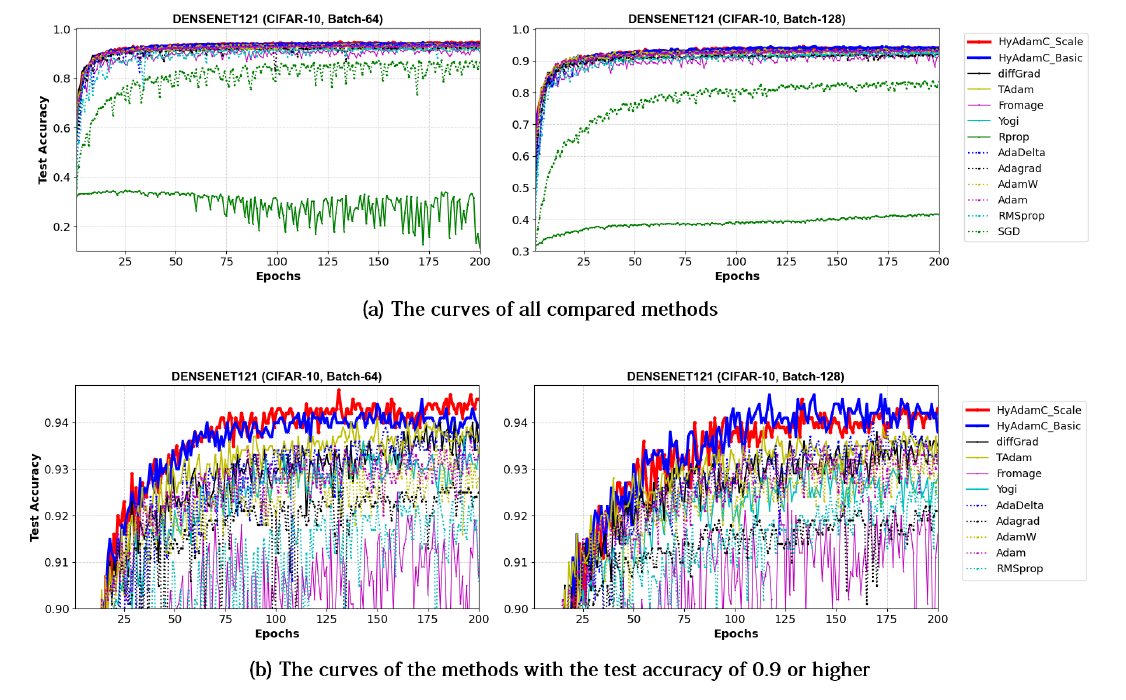
Figure 23. The test accuracy curves of the DenseNet-121 trained by HyAdamC and other optimization methods in the CIFAR-10 image classification tasks. In this figure, ( a ) shows the test accuracy curves of all compared methods. On the other hand, ( b ) illustrates the plots in which a range of the y-axis of the plots described in ( a ) is zoomed into between 0.9 and 0.95.